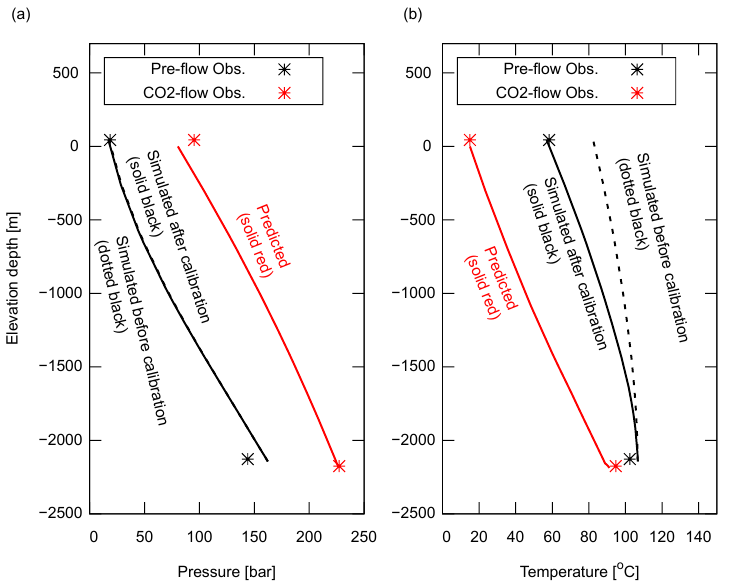
Figure A4. Results of the computed pressure, P , ( a ) and temperature, T , ( b ) in the wellbore. The input parameters were calibrated using the observed P and T at both the wellhead and downhole conditions during the pre-flow back period shown by the black dotted line for that before the calibration and shown by the black solid line for that after the calibration. The same input parameters were used to predict P and T in the wellbore during CO 2 injection as shown in the red line. A good agreement with the measured data was obtained for the CO 2